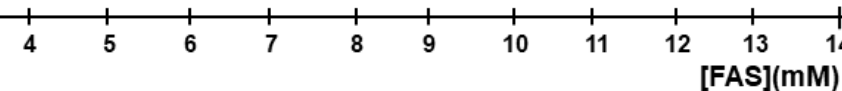
Figure 2. Growth inhibitory effect of iron on Saccharomyces strains. Horizontal segments represent the range of FAS concentrations between NIC (left-end) and MIC (right-end), for each yeast strain. Data and error bars represent the average and standard deviation of three independent biological replicates. The colors of segments and strain abbreviations are species-dependent according to Figure 1.